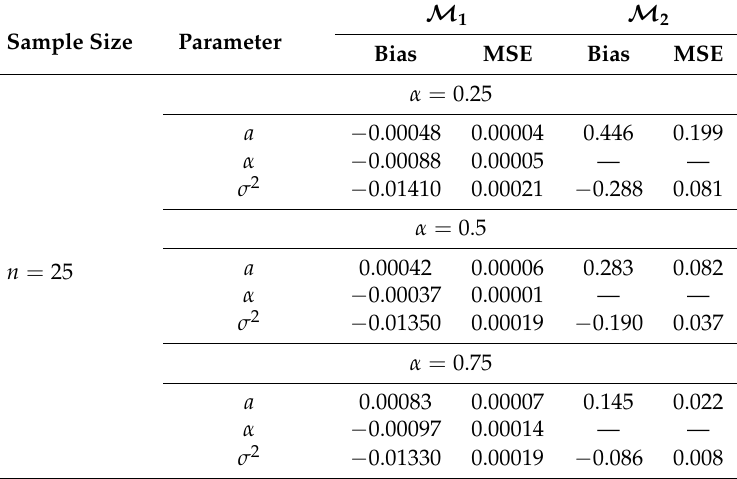
Table 1. Estimation of Bias and